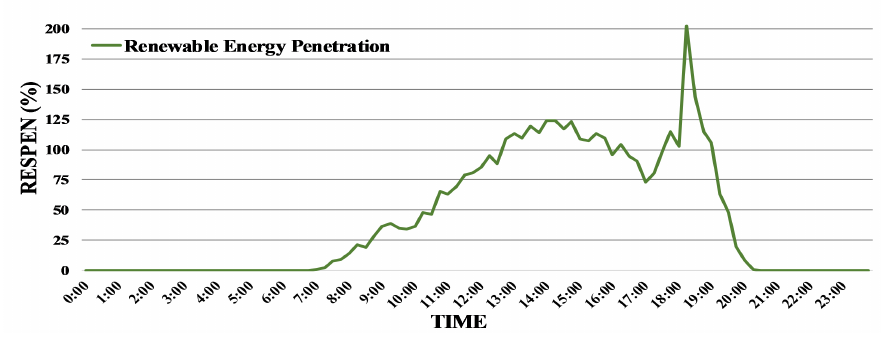
Figure 7. Renewable Energy Resources (RES) Penetration on the 23 August 2019.